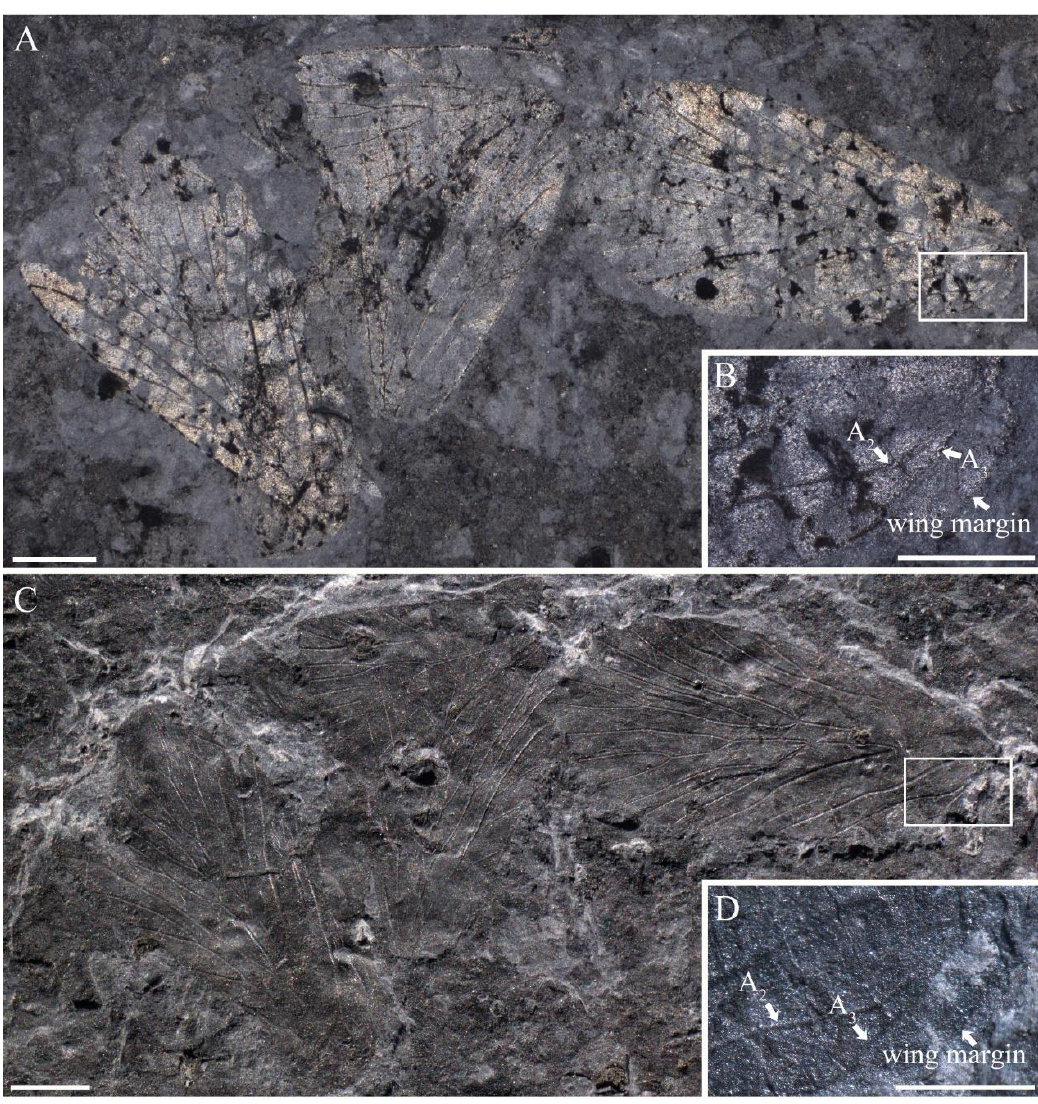
Figure 10. Sinoagetopanorpa elegans sp. nov., NIGP200921 (holotype). ( A ) Photograph was taken when specimen immersed under 70% alcohol in vertical reflected light; ( B ) Enlargement from ( A ); ( C ) Photograph was taken in oblique reflected light; ( D ) Enlargement from ( C ). Scale bars represent 1 mm in ( A , C ), 0.5 mm in ( B , D ). Material . Holotype, NIGP200921 (Figures 10 and 11), two forewings and two hind wings preserved in one specimen, interpreted as one individual. One forewing is well- preserved, the other forewing lacking apex; two hind wings overlap with each other, poorly preserved. Description . Forewing with apex rounded, base obviously shrunken, the complete forewing length 5.6 mm, width 2.6 mm, L/M 2.2; dark color denser at the apical wing than basal wing, costal area with 5 – 6 hyaline patches; Sc terminated at a distance of 3.9 mm from wing base; R 1 single, smoothly curved near apex; pterostigma large, half below the apical R 1 ; Rs five-branched, Rs 4 bifurcated into two terminal branches, Rs 1 curved up- wards, Rs 1+2 fork at the same level as M 1+2 fork, stem Rs 1+2 1.5 times as long as stem Rs 3+4 , stem Rs 4a+b long and 1.5 times as long as its branches; M six-branched, M 2 bifurcating into two branches, stem M 1+2 about 1.5 – 1.7 times as long as stem M 3+4 , the three branches of M 3+4 forking close, resulting in one forewing with M 3 two-branched and M 4 single, the other forewing with M 3 single and M 4 two-branched; a crossvein connecting stem Rs 3+4 and M 1+2 , stem M 2a+b and M 3 , respectively, crossvein m-cua connecting basal M 4 (or M 4b )